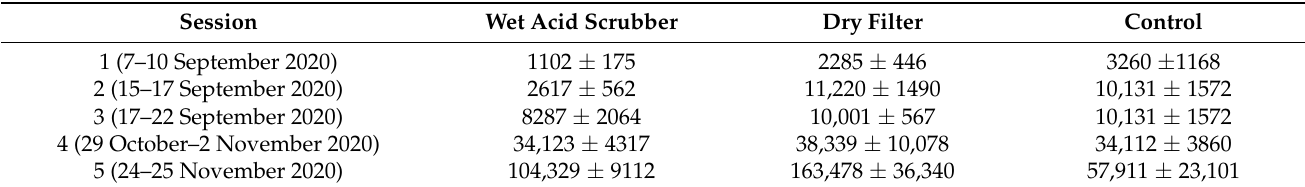
Table 4. Average ± standard deviation odor concentrations (ouE m − 3 ) for each abatement system and for the control room. Session Wet Acid Scrubber Dry